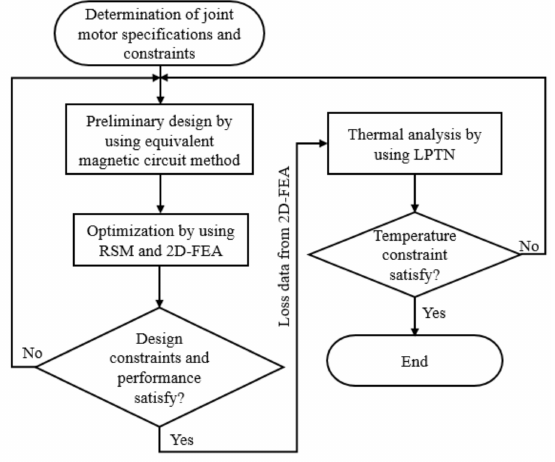
Figure 10. Joint motor design